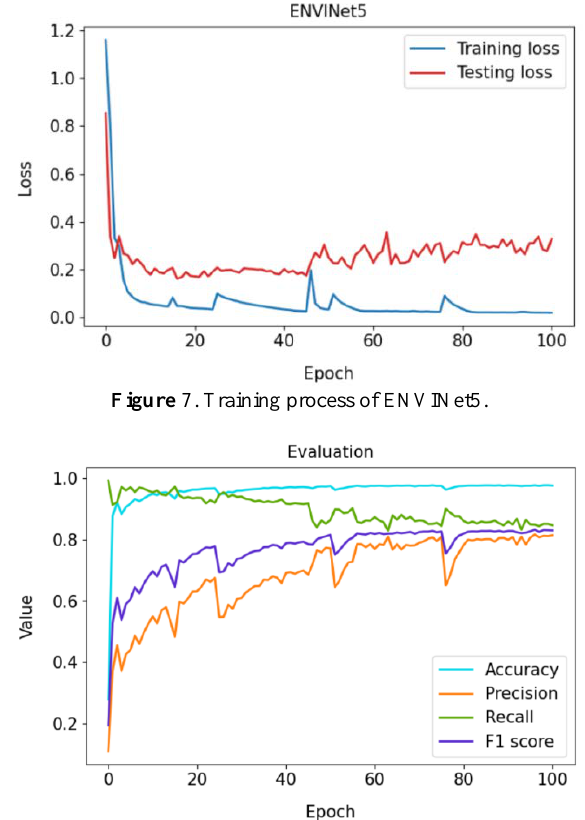
Figure 8. Evaluation of ENVINet5 using validation sets with accuracy, precision, recall, and F1 score indices.